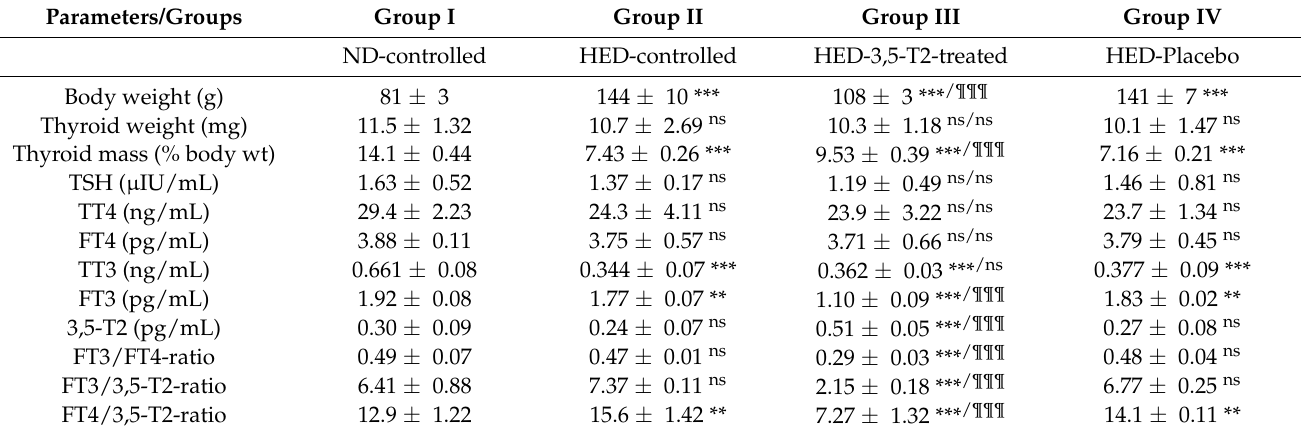
Table 1. In vivo effects of 3,5-T2 on thyroid hormones plasma levels from experimental P. obesus